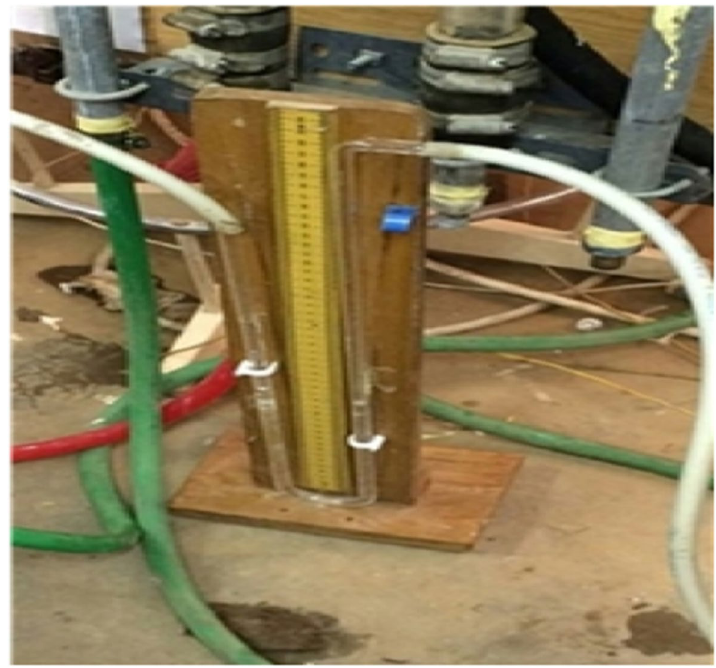
Fig. 6 Photographic of air